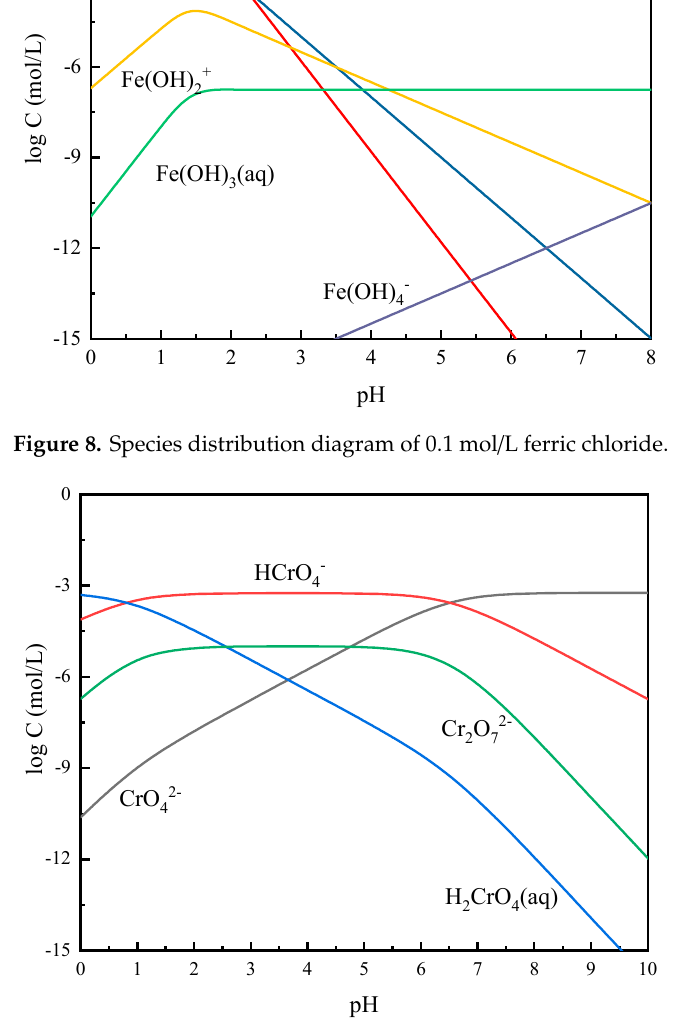
Figure 9. Species distribution diagram of 2.72 × 10 – 4 mol/L Cr( Ⅵ ).